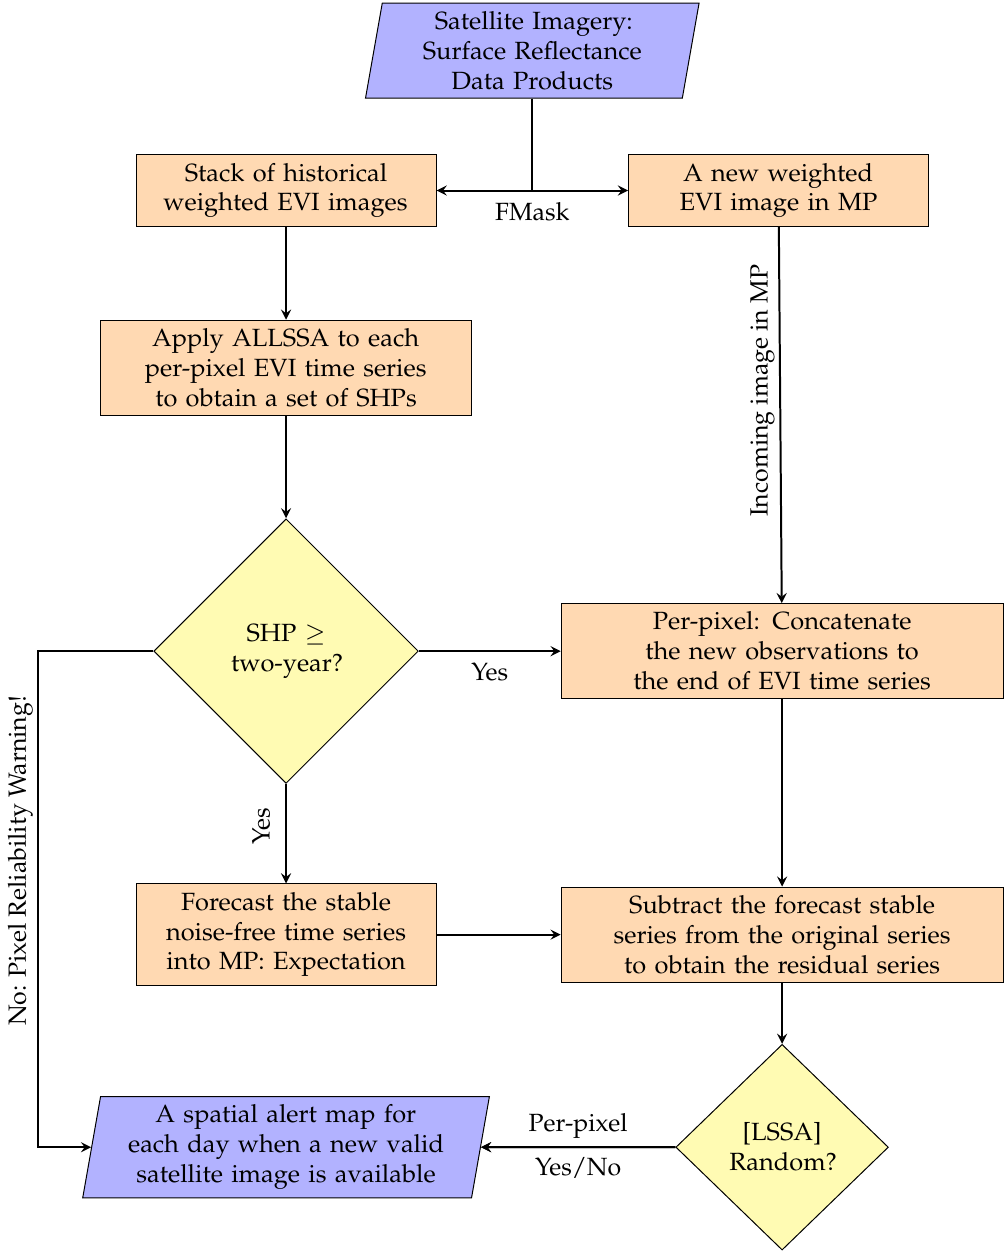
Figure 3. Flowchart of the monitoring algorithm. The disturbance detection process using ALLSSA and LSSA is independently applied to each per-pixel EVI time series. One may also use other spectral indices instead of EVI in this algorithm, such as NDVI. An appropriate weight may be assigned to each pixel value based on the uncertainties in the presence of cloud/shadow, snow, ice, smoke, and haze using a cloud-masking algorithm, such as FMask. Please note that the process of selecting SHP corresponding to each pixel is performed only once, and the new observations during MP will be concatenated to the end of time series as they become